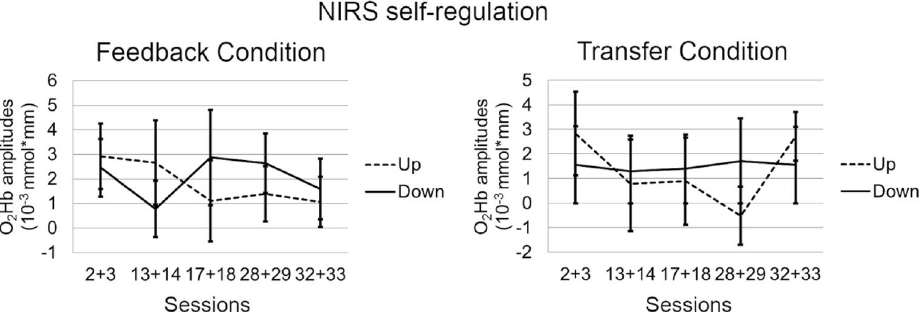
Figure 4. Self-regulation of O 2 Hb amplitude by task (polarity; upregulation vs. downregulation) and condition (feedback vs. transfer) averaged over left and right ROI channels. The figure shows the non-inverted O 2 Hb amplitudes (opposite to the online feedback